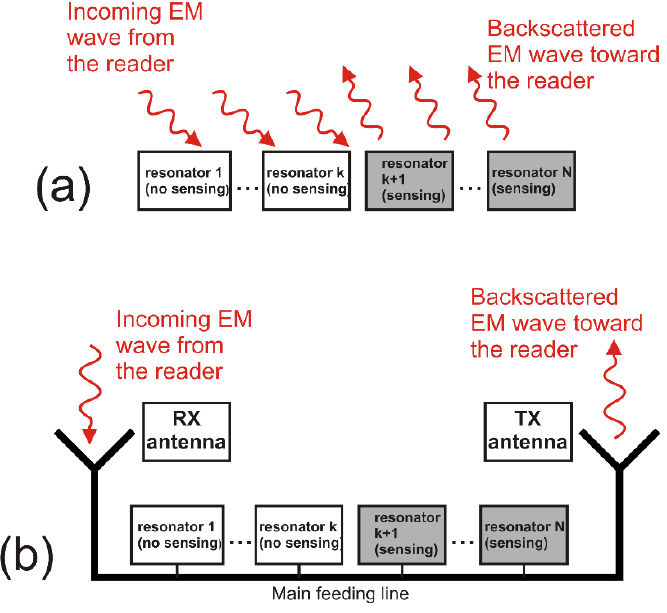
Figure 4. Chipless RFID sensor tag structure including both sensing and coding resonators. ( a ) Backscattered chipless tag. ( b ) Retransmission-based chipless tag.